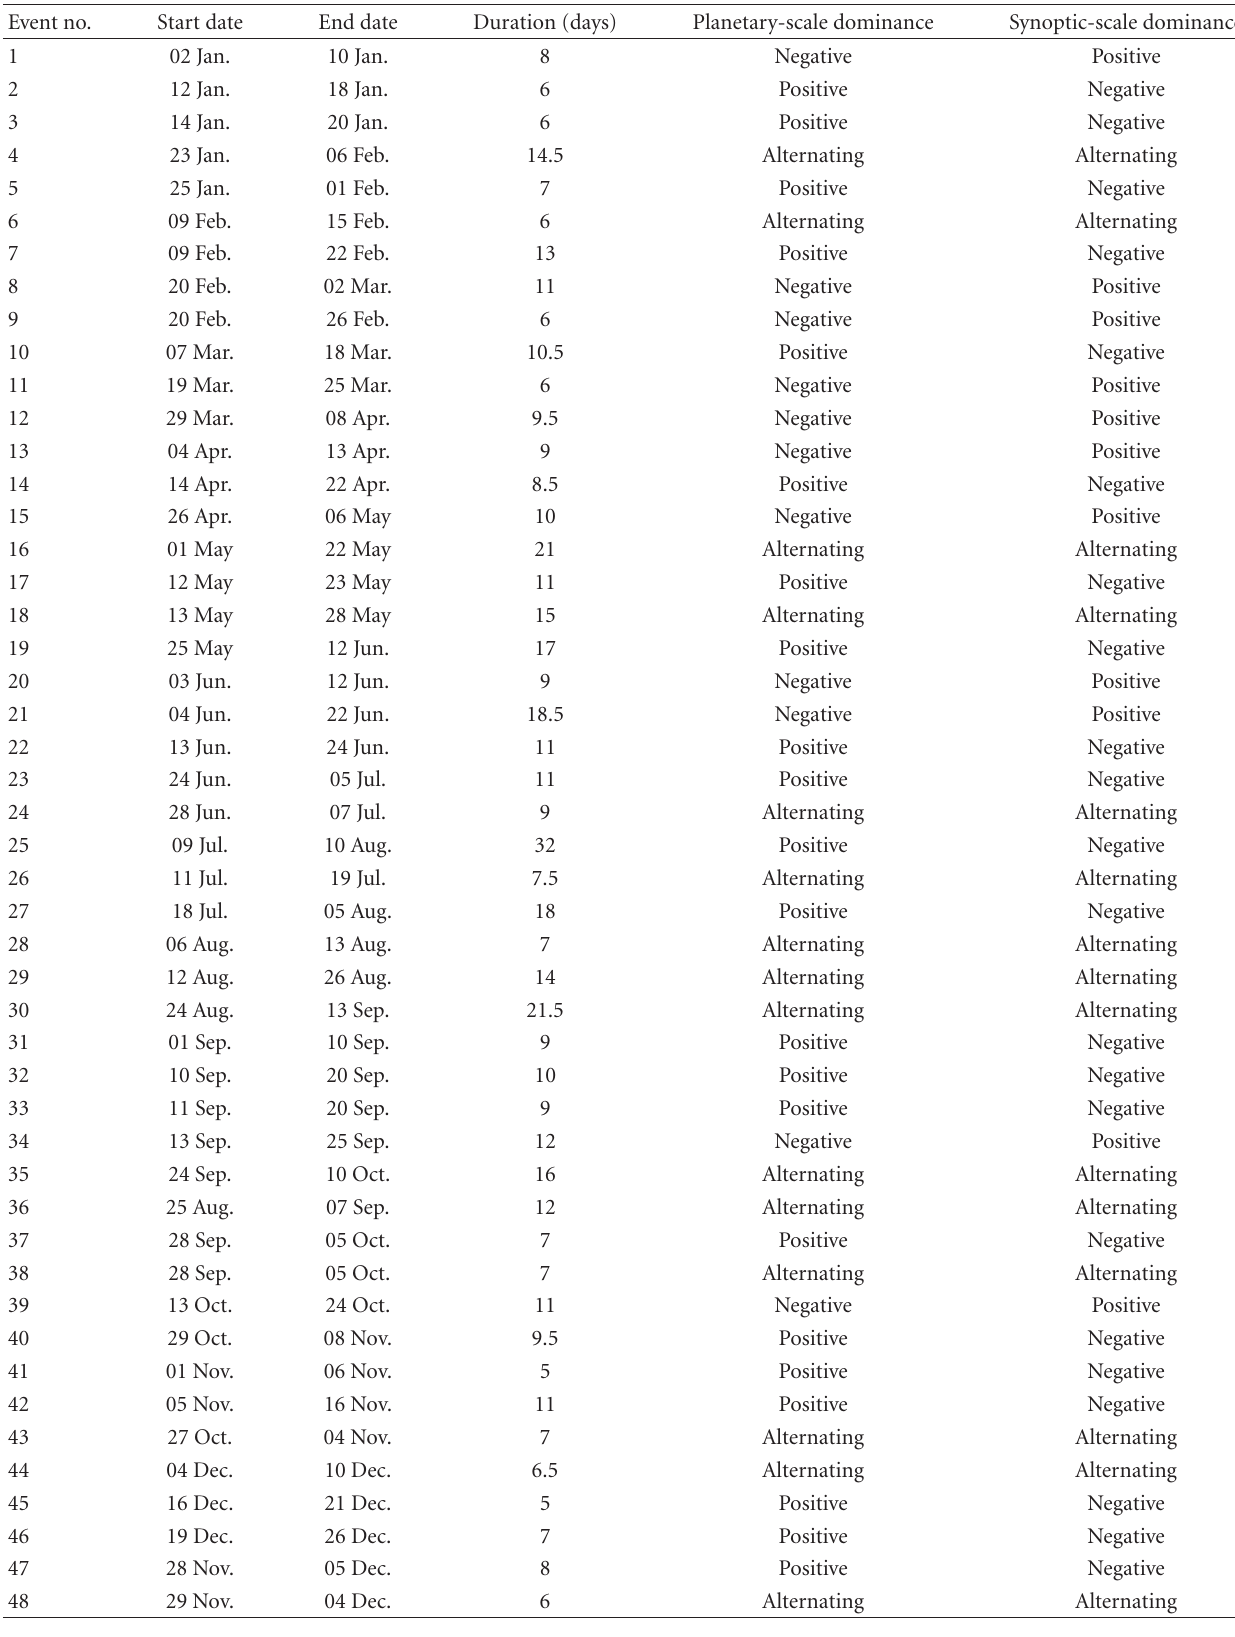
Table 5: Same as Table 4 except for the year